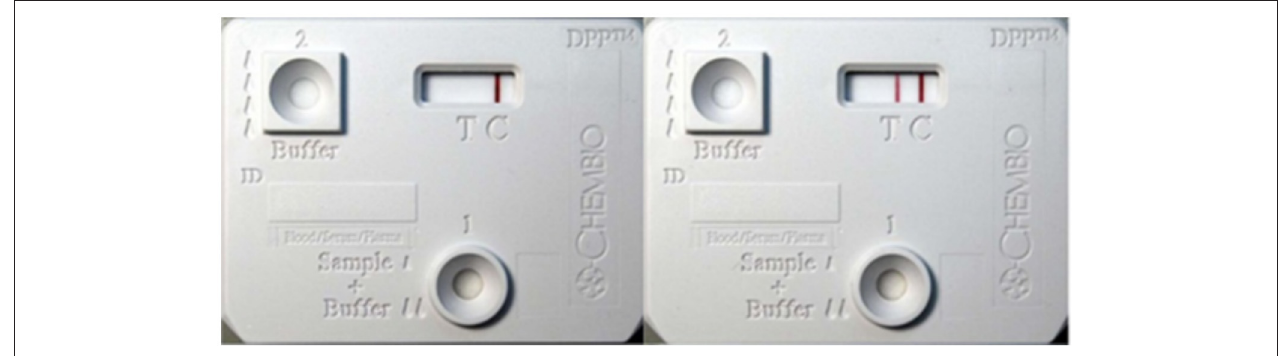
FIGURE 1 | Dual-path platform assay kit showing positive and negative controls. Dual-path platform assay was used to detect circulating antigen-antibody complexes in calves infected with Mycobacterium bovis . The rabbit polyclonal antibodies immobilized on the test line(T) acted as the capture reagent for the circulating immune-complexes in the infected animal’s serum as well as signal detector when coated onto nano-gold-particles. DPP strip case: Left : Negative Control (serum from uninfected animals), Right : Positive control.